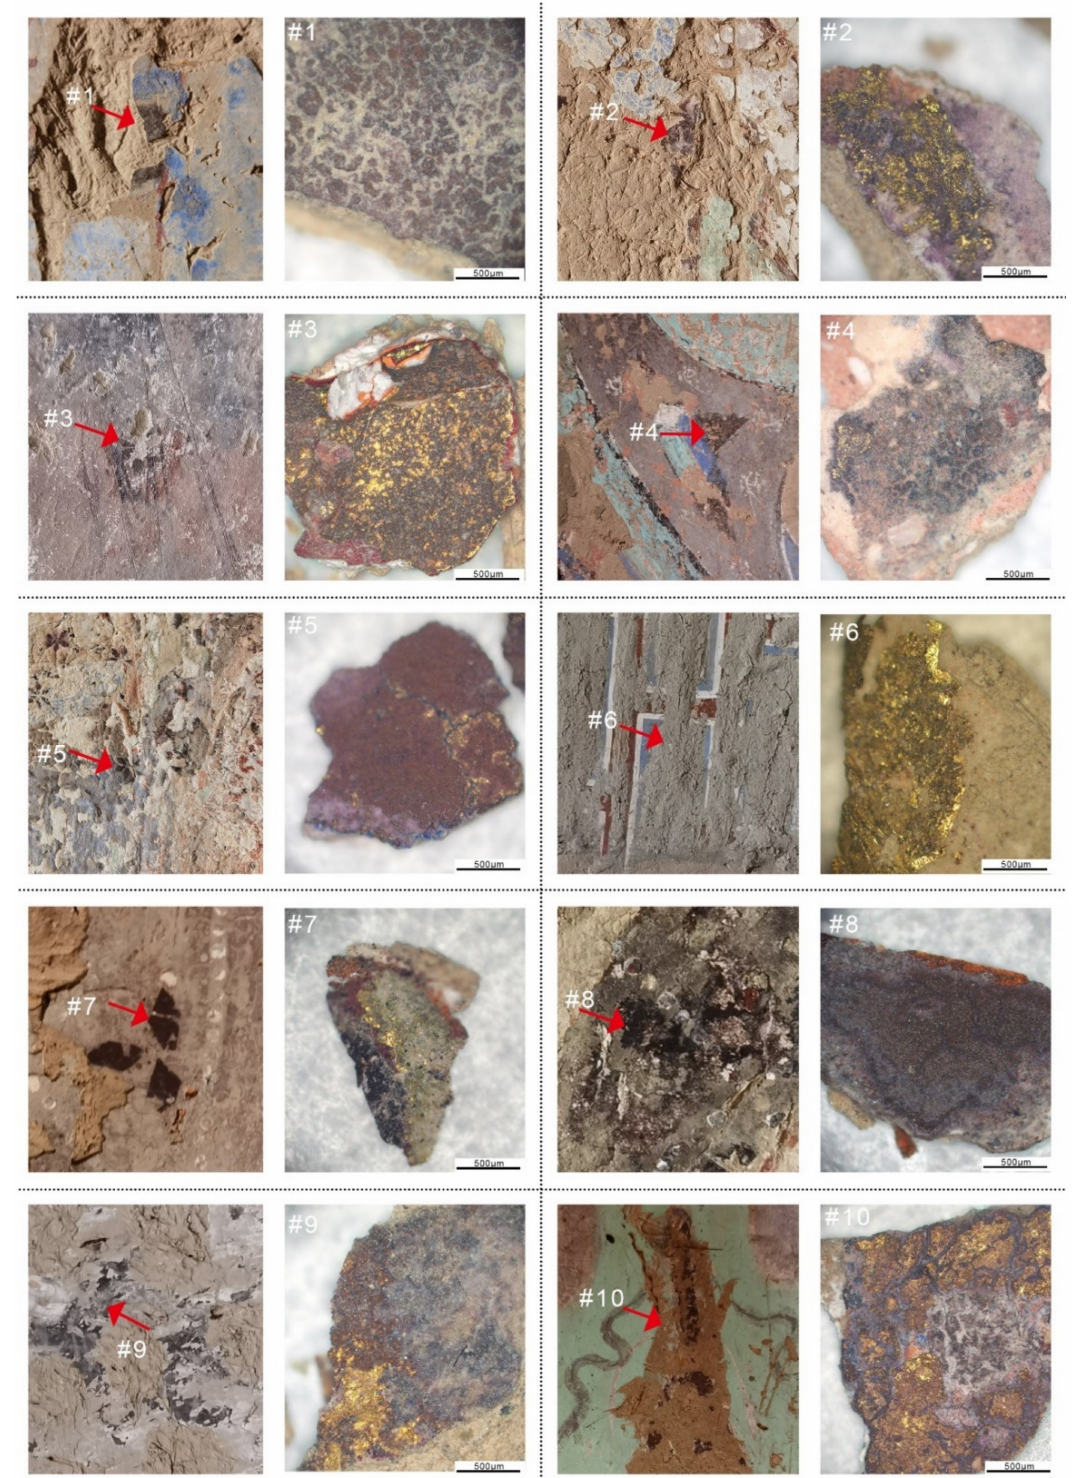
Figure 2. Sampling locations and microscope images of the samples used in this study. The red arrow in the images means the sampling